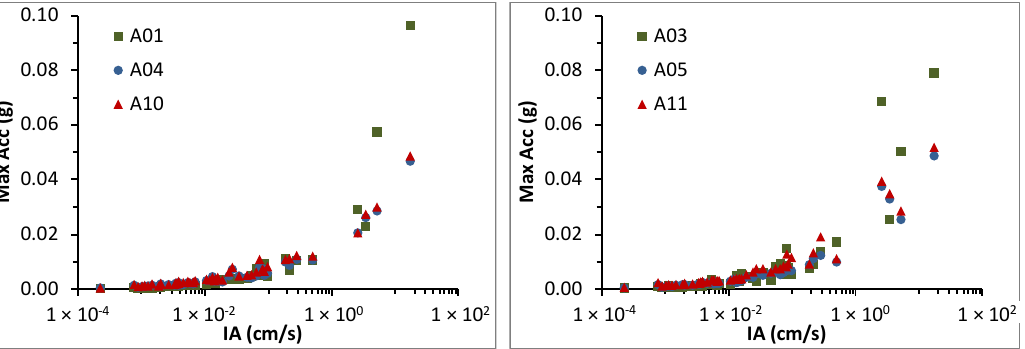
Figure 13. Magnitude versus epicenter distance for the recorded events. The areas of the circles are proportional to I A , except for events with M < 5.